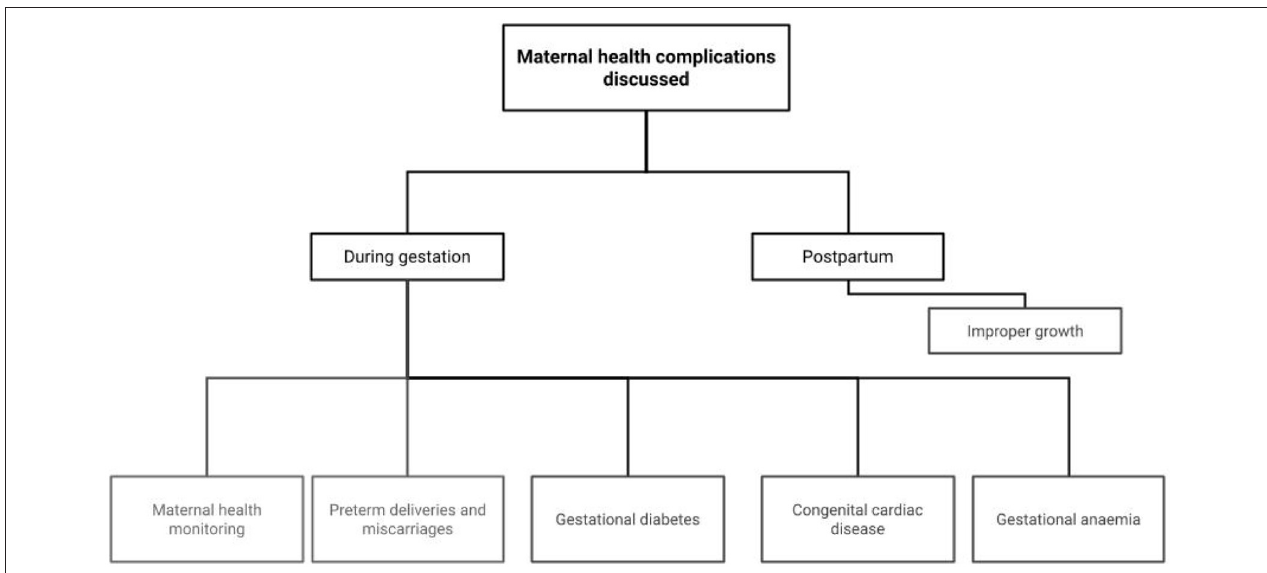
FIGURE 7 | Focus areas on role of AI in complimenting maternal